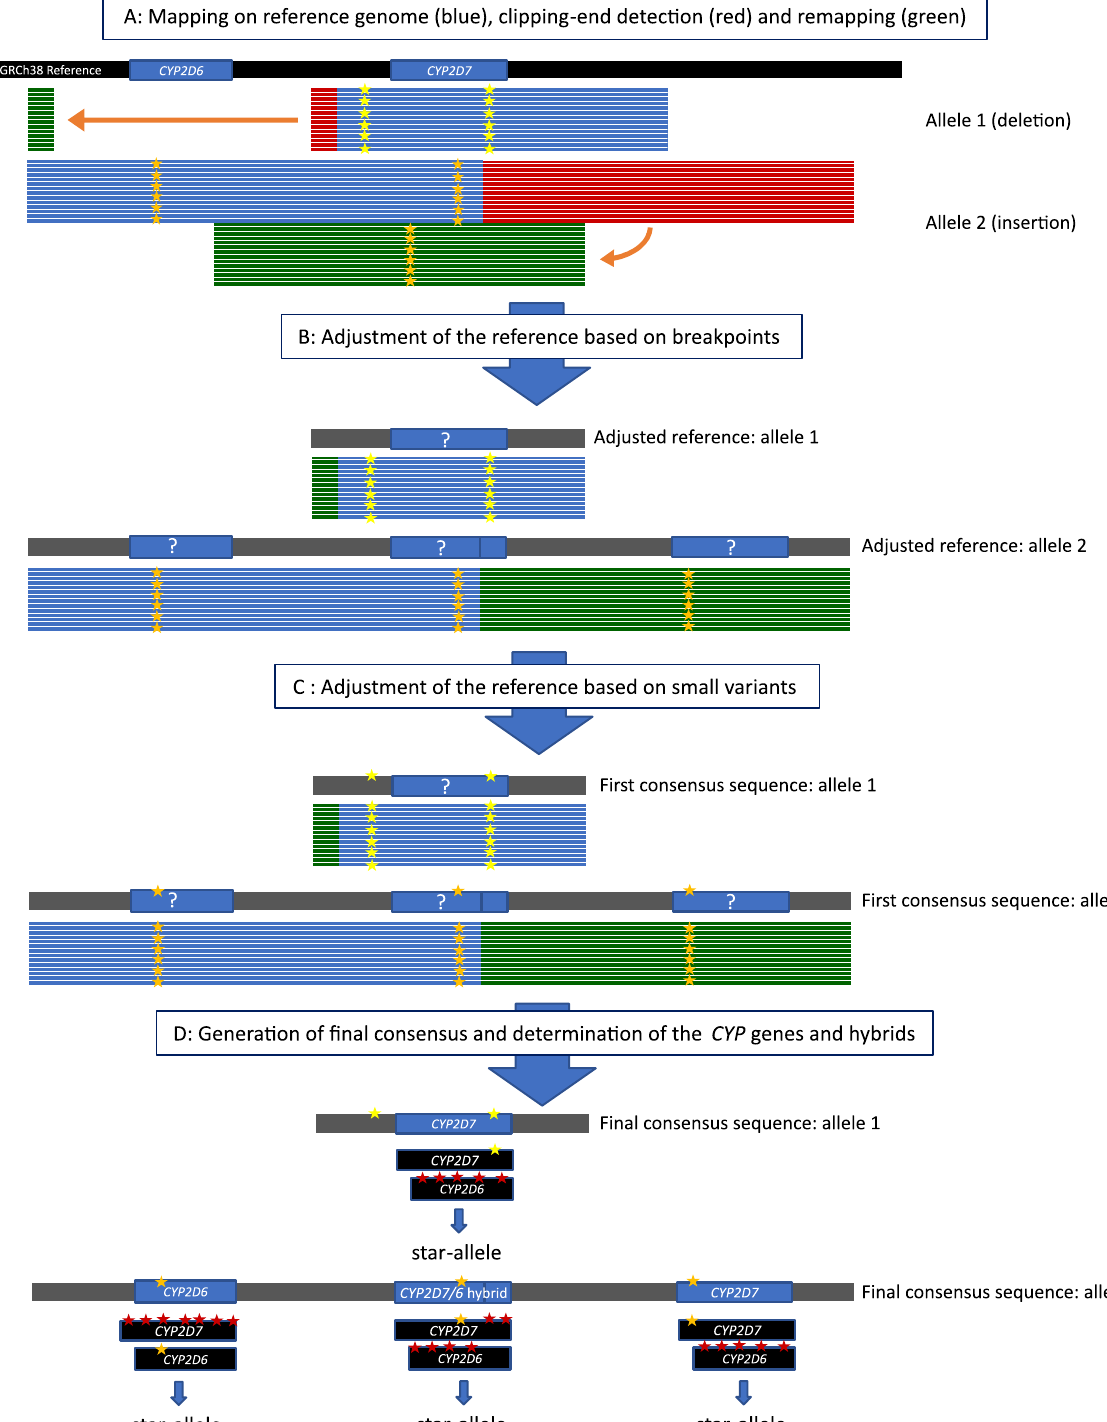
PLOS Genetics | https://doi.org/10.1371/journal.pgen.1010176 September 23,